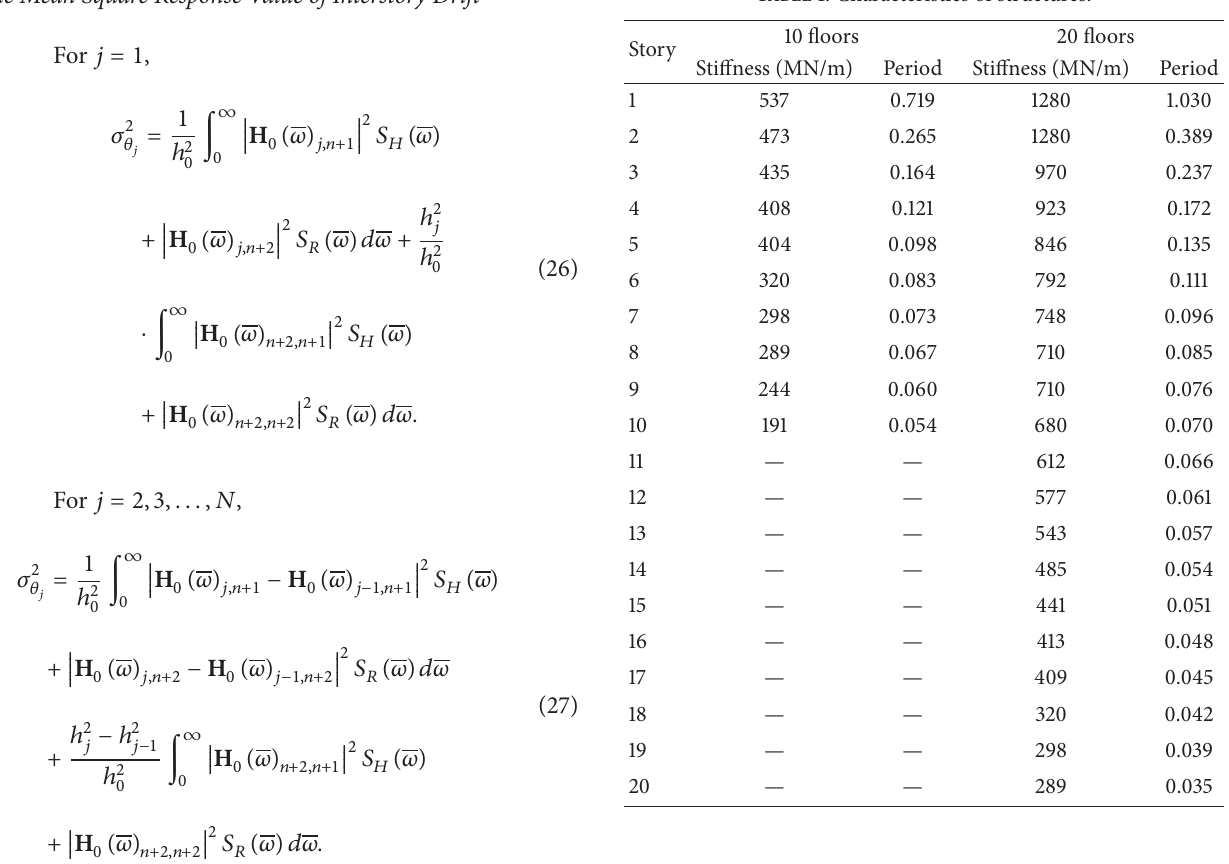
Table 1: Characteristics of